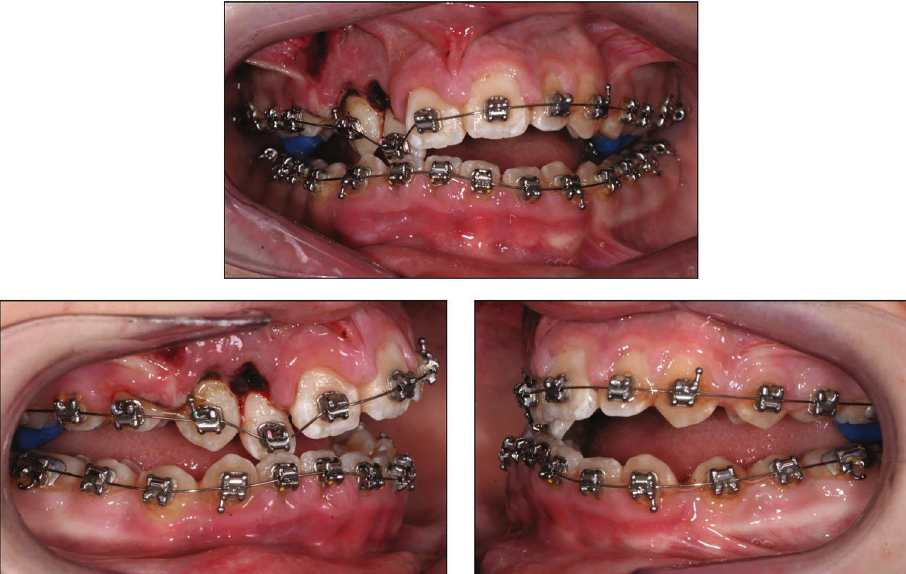
Figure 8: The patient ’ s intraoral photographs taken directly after starting leveling and alignment with the 0.012 ″ Ni – Ti round wires, one day after the dental trauma.